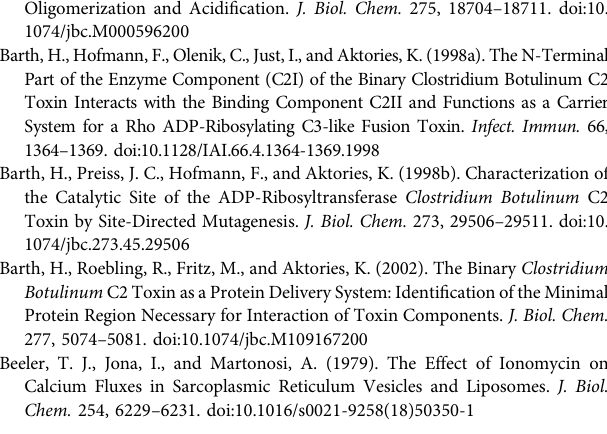
Supplementary Figure S1 | Analysis of recombinant C2I, C2II and C2IIa. The recombinant proteins were puri fi ed and C2IIa was activated as described in Materials and Methods . Proteins were subjected to 12.5% SDS-PAGE and analyzed by Coomassie blue staining (750 ng of each protein, left panel) or by Western blotting with speci fi c antisera against C2I or C2II (350 ng of each protein, right and middle panel, respectively). Supplementary Figure S2 | Effect of C2IIa on the morphology of primary human PMNs. Primary human PMNs were incubated without (Ctrl.) or with increasing concentrations of C2IIa at 37 ° C and analyzed by phase contrast microscopy. Pictures of the cells were taken 2 min before (indicated as untreated, UT) and immediately after protein addition into the medium (indicated as time point 0) and after 0.5, 1 and 6 h. The percentage of morphologically changed cells was quanti fi ed from the pictures. Data is representative for three independent experiments. Values represent the mean ± SD of three technical replicates. Supplementary Figure S3 | The ability of C2IIa to mediate intracellular Ca 2+ mobilization depends on the level of C2IIa stimulation. Primary human PMNs were loaded with Indo-1-AM. After pre-warming to 37 ° C, the cells were applied to the fl ow cytometer and the Ca 2+ baseline was determined for 2 min. Subsequently, the cells were treated for 4 min with 0.2, 0.6, 1, 2, 5 and 10 µg/ml of C2IIa or with the PBS as control. Subsequently, ionomycin was added to the samples for 3 min. The individual points shown in the curves correspond to the times in full seconds versus the medians of all fl uorescence ratios representing [Ca 2+ ] i , following their normalization according to the maximal values reached after addition of 2 μ M ionomycin. Data is representative for three independent experiments. Supplementary Figure S4 | Effect of C2IIa and C2IIa + C2I on the viability of primary human PMNs ex vivo . Primary human PMNs were incubated without any protein (Ctrl.) or with either C2IIa (2 µg/ml) or complete C2 toxin (2 µg/ml C2IIa + 1 µg/ml C2I) at 37 ° C. After 6 h, the amount of viable cells was determined with the MTS cell viability assay and the percentage of viable cells calculated. Data is representative for three independent experiments. Values represent the mean ± SD of three technical